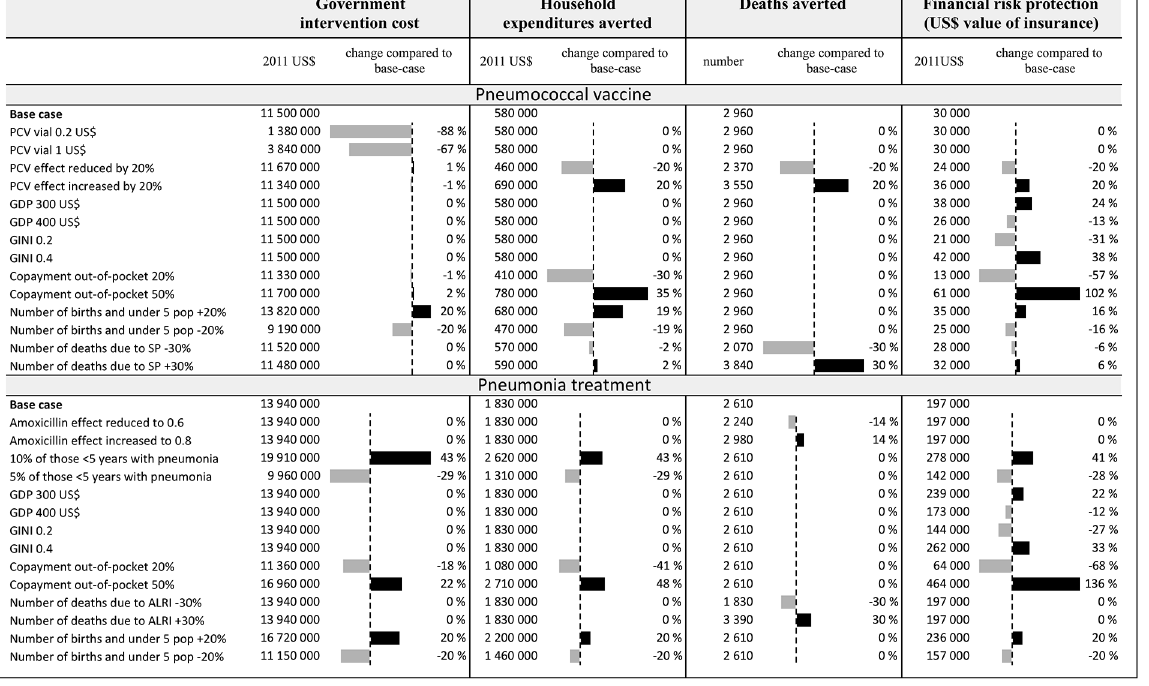
Fig 4. Uncertainty analysis for each of the two policies (universal public finance of pneumonia treatment and pneumococcal vaccines) in Ethiopia, key variables are modified as a one-way deterministic sensitivity analyses, (for more detailed results across income quintiles see S2 – S4 Tables).